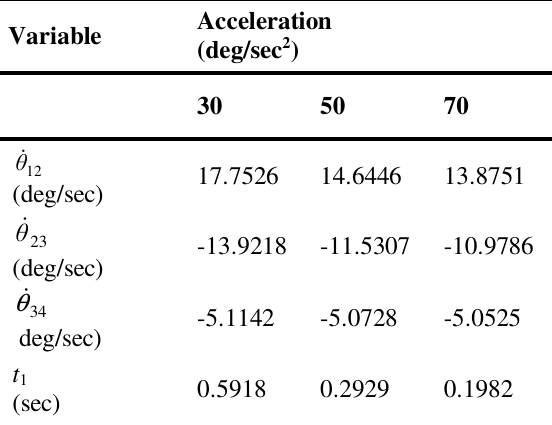
Optimal values obtained by proposed